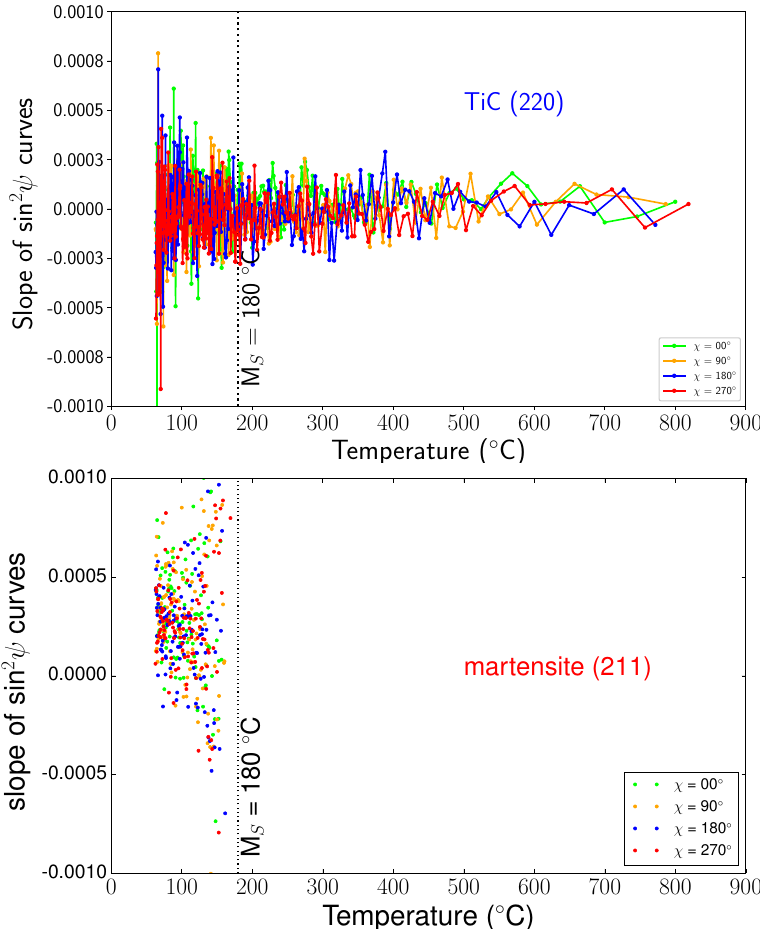
Figure 11. Evolution of the slopes of the sin 2 Ψ curve versus temperature for steel- γ phase, TiC, and steel- α (cid:48) phase.